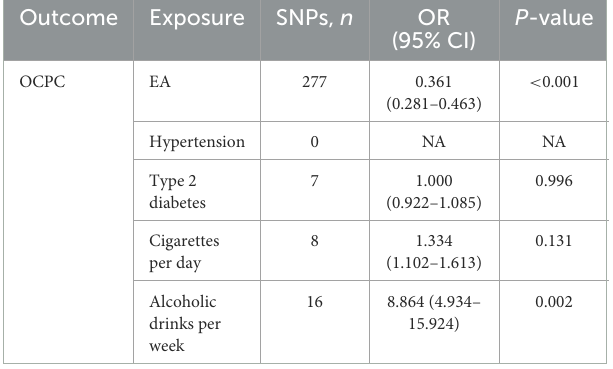
TABLE 3 MVMR results for